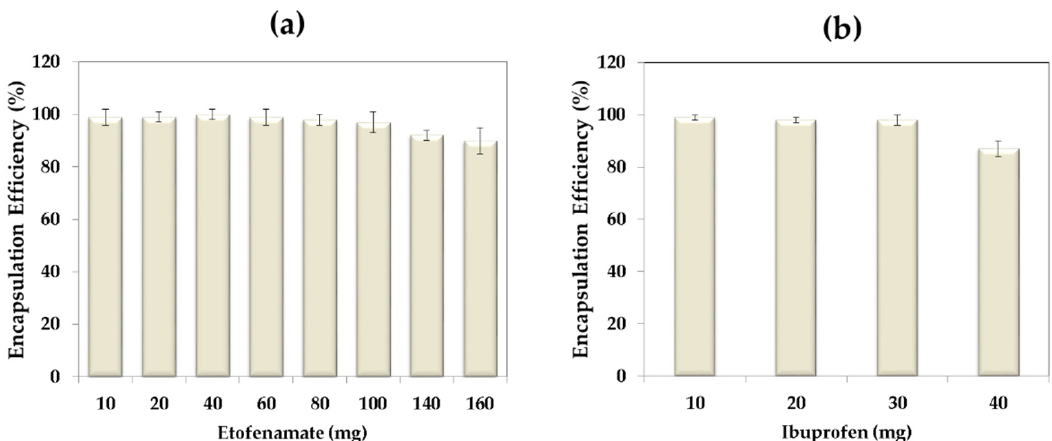
Figure 3. Encapsulation efficiency of etofenamate ( a ) and ibuprofen ( b ) in SLN. Values represent the mean ± S.D.; n = 3.